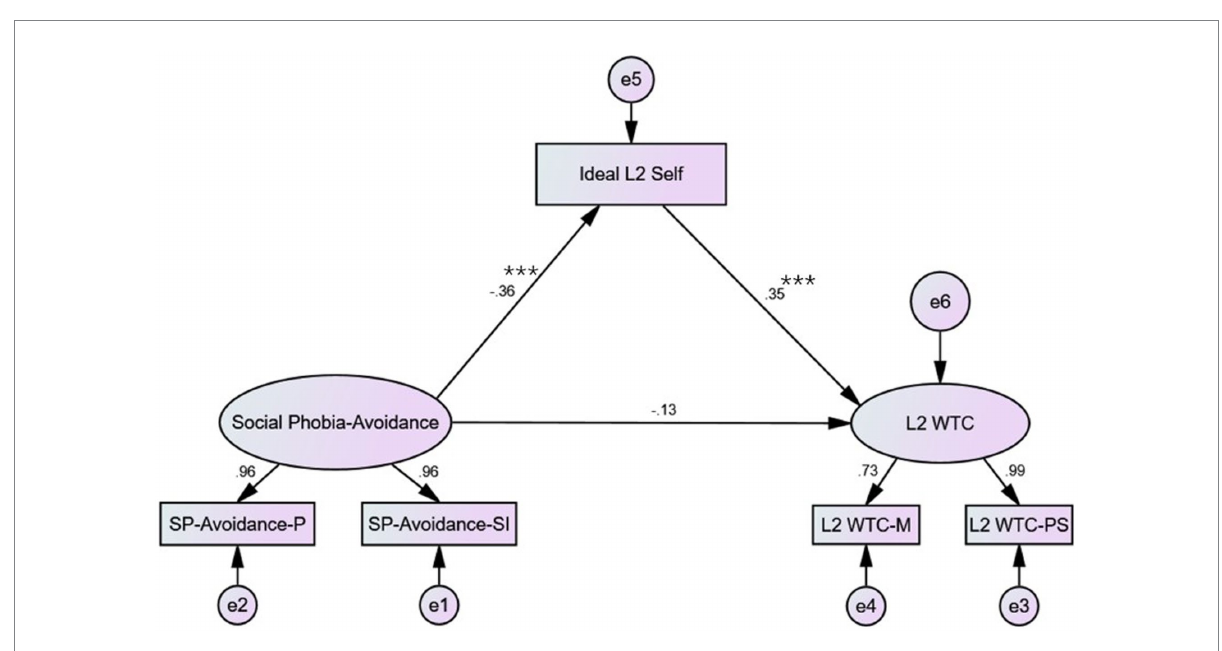
FIGURE 3 Path analysis – Social phobia-avoidance; *** p <